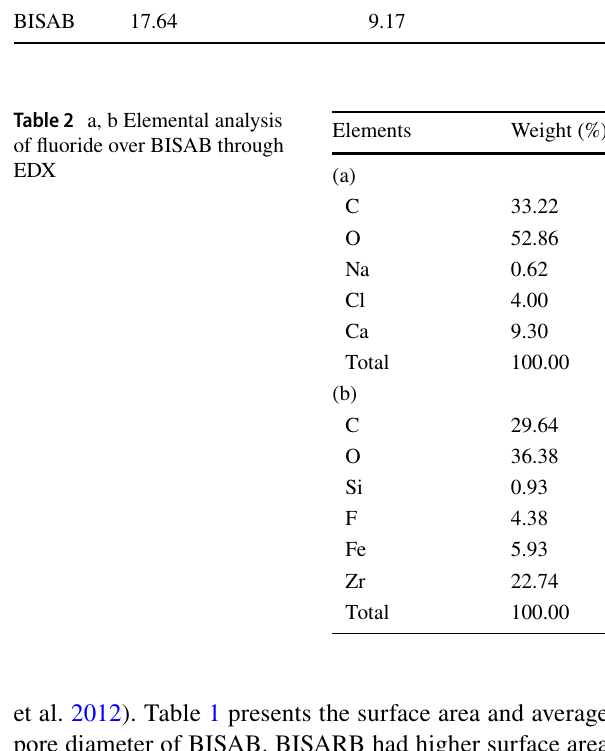
Table 1 Surface characterization of BISAB